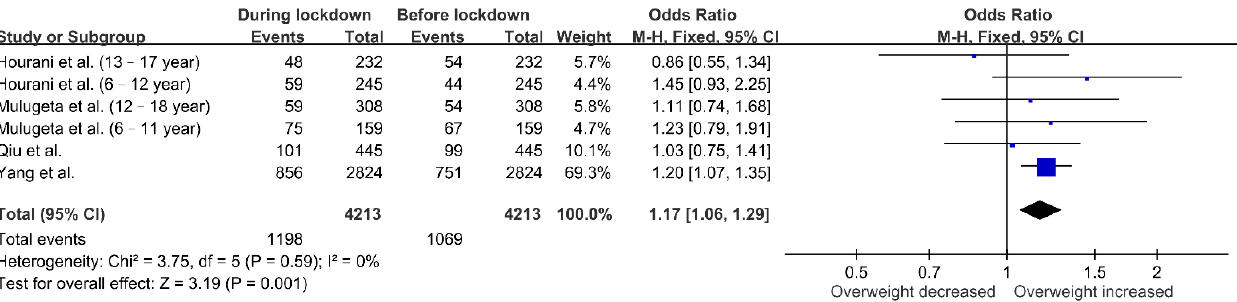
Figure 5. Associations between lockdown and overweight in children. The proportion of overweight children increased during lockdown.